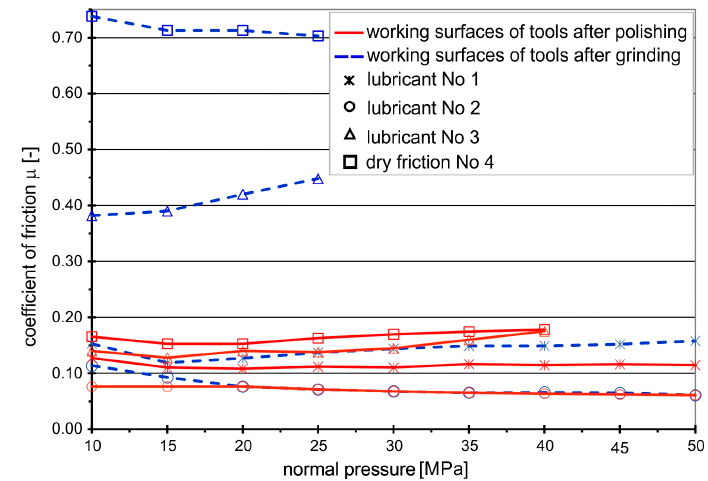
Figure 3. Coefficients of friction for frictional pair “titanium Grade 2–steel NC10”.